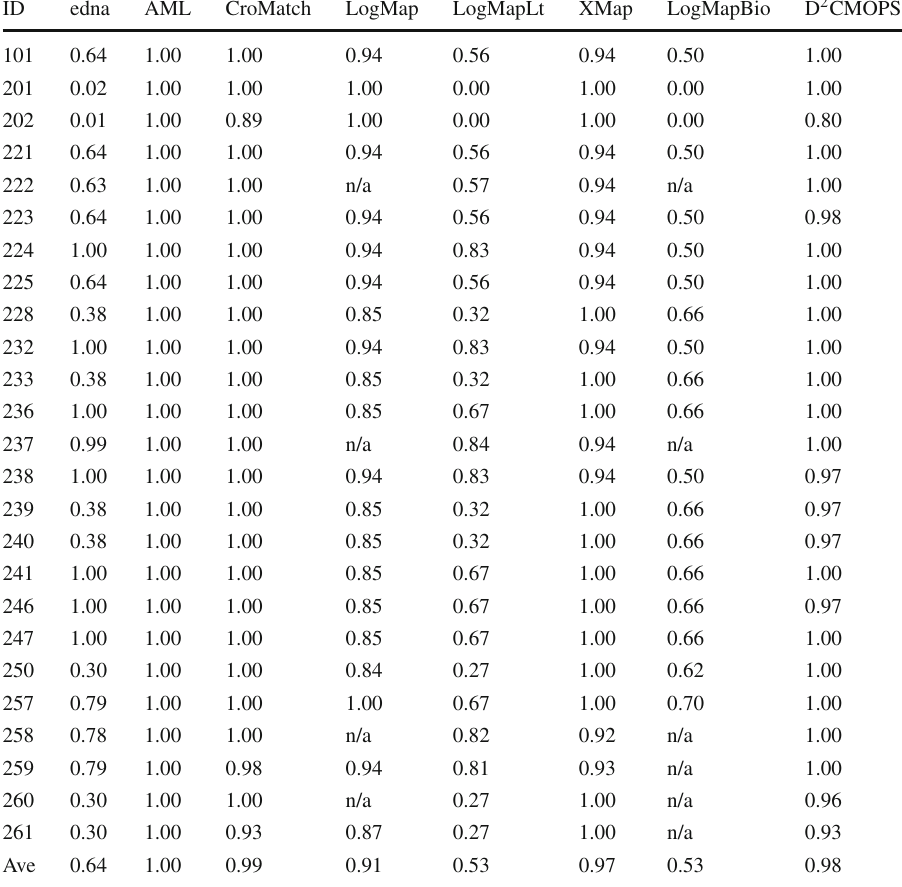
Table 16 Comparison on OAEI’s participants and D 2 CMOPSO in terms of precision in benchmark